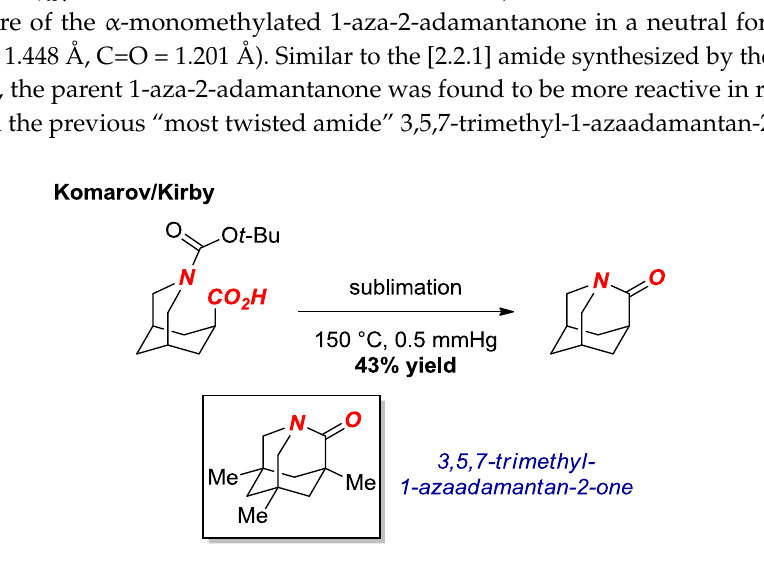
Figure 7. Synthesis of Parent 1-Azaadamantan-2-one.